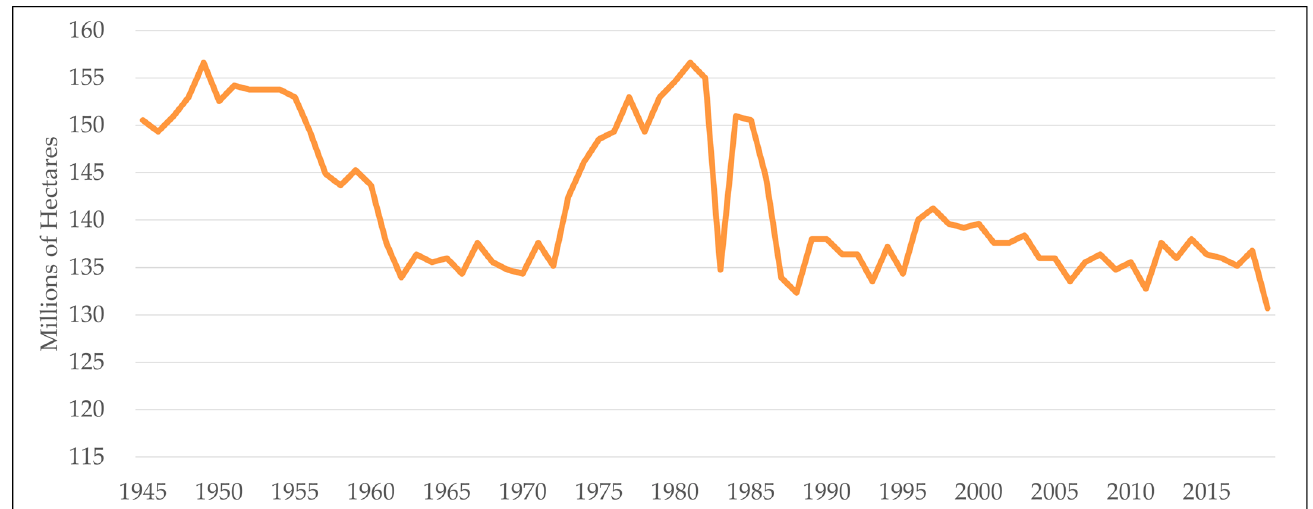
Figure 1. Land in Crops in the USA from 1945 to 2019 according to the USDA Major Land Uses Dataset.